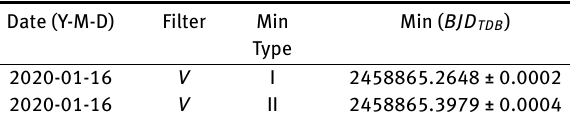
Table 2. The new times of minima for V1848 Ori in V